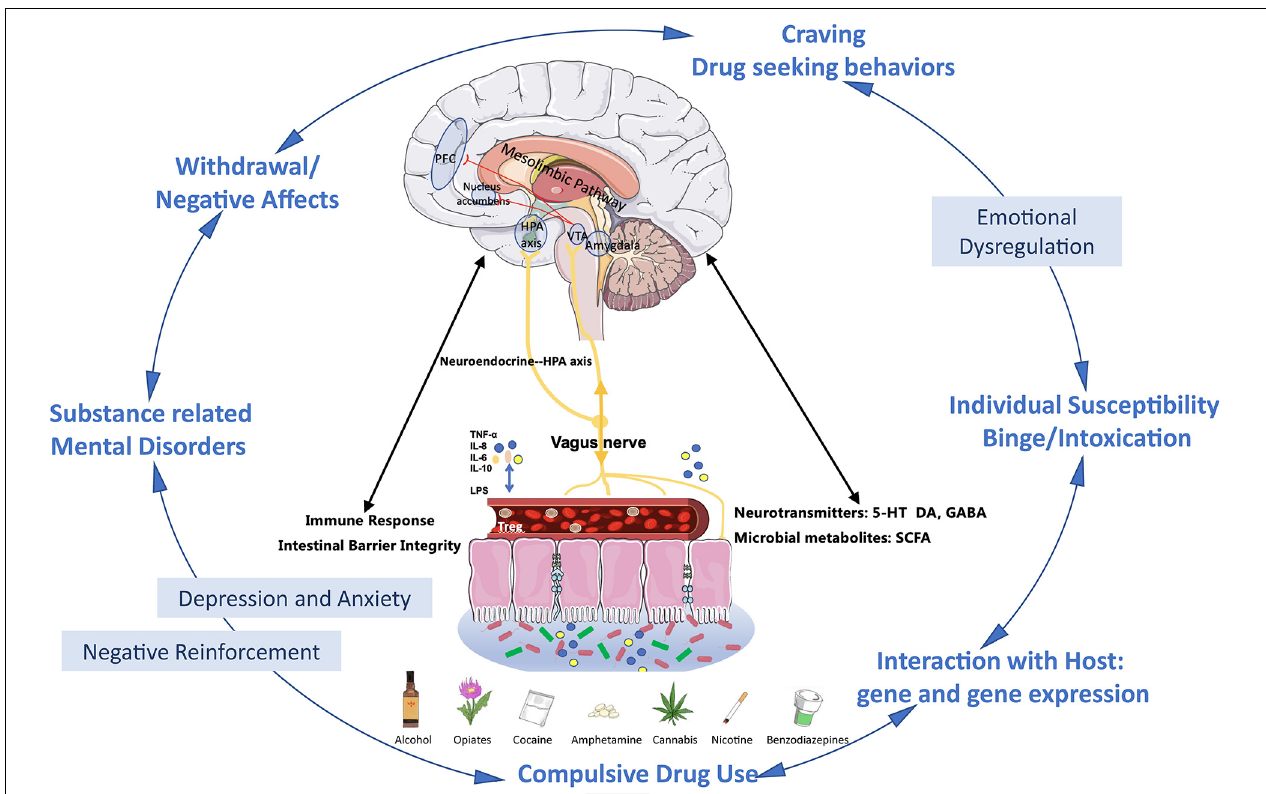
FIGURE 1 | Microbiome–gut–brain in substance use disorders and substance-related mental disorders. First, via the microbiome–gut–brain axis, substance exposure-induced dysbiosis leads to the damage of the gut epithelial barrier. In turn, it further causes the increased permeability (“leaky gut”) of bacterial products such as LPS lipopolysaccharide (LPS), immune cytokines (TNF- α , IL-6, IL-8, IL-10, etc.), hormones, neurotransmitters, and microbial metabolites produced by the gut microbiome. These products can be released to the systemic circulation such as blood stream and then transported to the brain, and these gut derived components also target the HPA axis and vagus nerve. These all together further impact on brain barrier integrity and immunoactivities in brains and alter the reward system (Carbia et al., 2021; Garcia-Cabrerizo et al., 2021). Second, the gut microbiome plays an important role in the cycle of development and maintenance of addiction. At the binge/intoxication stage, substance use is mainly initiated by individual susceptibility of the drug, which might be determined by the interaction between the microbiome and the host genetic background. In this stage, the same emotional problems might also precede the use of the drug. Repeated binge induces the progressively microbiome imbalances and contributes to early emotional dysregulation, and further motivates the craving and drug seeking behaviors. At the withdrawal/negative effect stage, exaggerated emotional disturbances and dysbiosis combine with the negative effects related to withdrawal driven negative reinforcement and finally accelerate the transition to compulsive alcohol use (Wise and Koob, 2014; Carbia et al., 2021; Garcia-Cabrerizo et al., 2021). Additionally, the substance-related mental disorders, especially depression and anxiety, could further exacerbate dysbiosis (Reyes et al., 2020; Carbia et al., 2021). Abbreviations: PFC, prefrontal cortex; VTA, ventral tegmental area; NAc, nucleus accumbens; AMYG, amygdala; NTS, nucleus tractus solitarii; IL, interleukin; TNF, tumor necrosis factor; LPS, lipopolysaccharide; SCFA, short-chain fatty acids; 5-HT, 5-hydroxytryptamine; DA, dopamine; GABA, γ -aminobutyric acid; HPA,